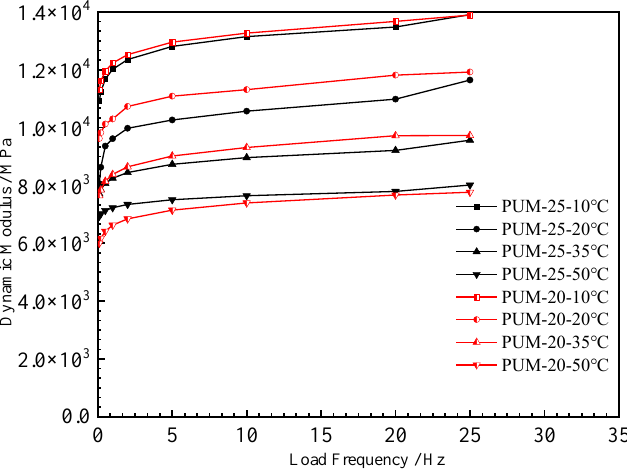
Figure 6. Dynamic modulus of PU mixtures.